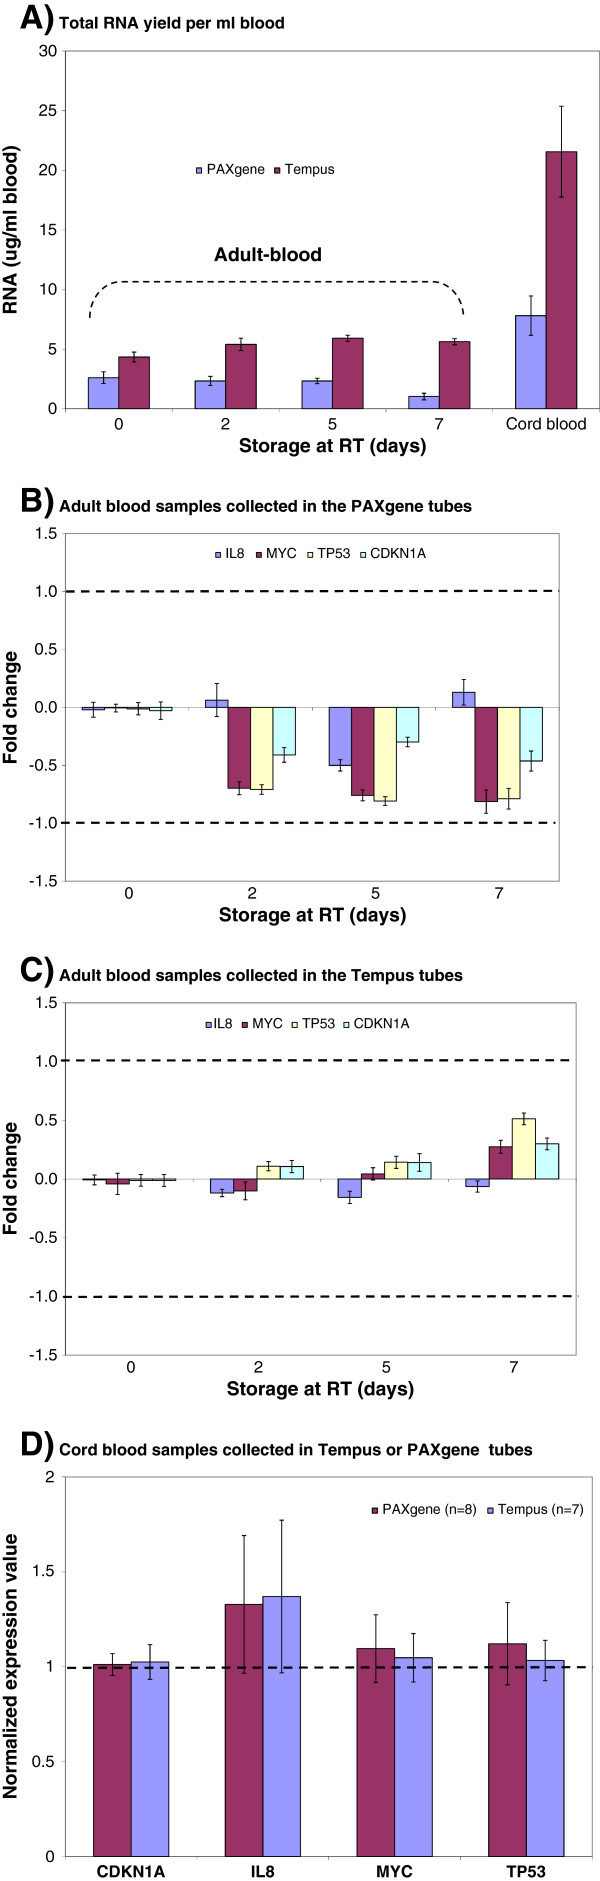
Comparison of PAXgene and Tempus tubes. Blood (adult or cord blood) was collected either in the PAXgene tubes or in the Tempus tubes, and stored at room temperature for the indicated number of days, followed by total RNA isolation. Five tubes were used at each time point (n=5). A) The RNA yield from the cord blood and the adult blood samples collected either in the PAXgene tubes or in the Tempus tubes. Each bar represents the average RNA yield per tube ± SE. B) Relative transcript levels of four genes from adult blood samples collected in the PAXgene tubes and stored for up to seven days at room temperature; C) Relative transcript levels of four genes from adult blood samples collected in the Tempus tubes and stored for up to seven days at room temperature. The 0 day samples were used as reference samples (calibrators); hence all other samples were compared against the reference samples. Each bar represents the average log2-transformed fold change values and the error bar indicates ± SE. The dashed lines indicate ± 2 – fold change. The fold change detected for the genes were within ± 2 – fold. D) The normalized expression values of four genes from cord blood samples collected in the PAXgene tubes (n=8) and in the Tempus tubes (n=7). Each bar represents the normalized expression values [2-ΔCq (sample); where the ΔCq (sample) ± Cq (gene) – Cq (internal control)] and the error bar indicates ± SE.